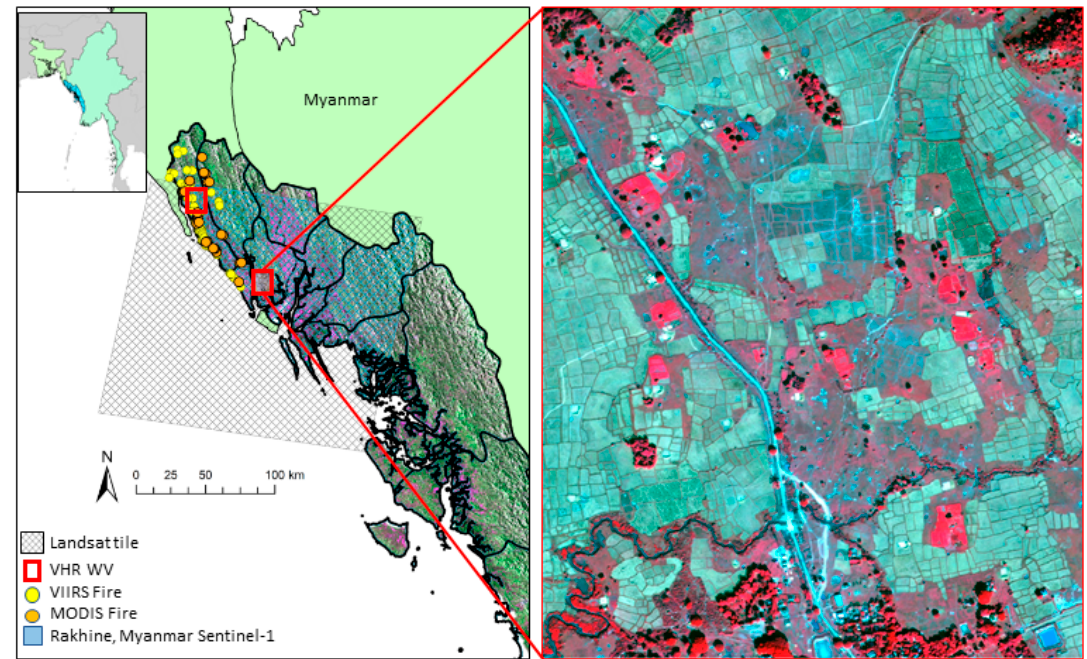
Figure 1. Rakhine State, Myanmar study region where conflict has amplified risks of food security and created additional challenges to assess and monitor crop production across the patchy landscape. ( Left ): Study region with fires as detected from VIIRS (Visible Infrared Imaging Radiometer Suite) and MODIS (Moderate Resolution Imaging Spectroradiometer) satellite fire products during the 2016–2018 crop periods, example Landsat tile scale, and location of very high resolution (VHR) World View (WV) imagery (red boxes) for case studies and algorithm tuning. ( Right ): Very high resolution snapshot, false color composite (4: Near-infrared, 3: Red, 2: Green) illustrating small patchy fields, forest lots, and other land uses (red tones show forest and scrub, brown show individual barren crop fields during dormant season).